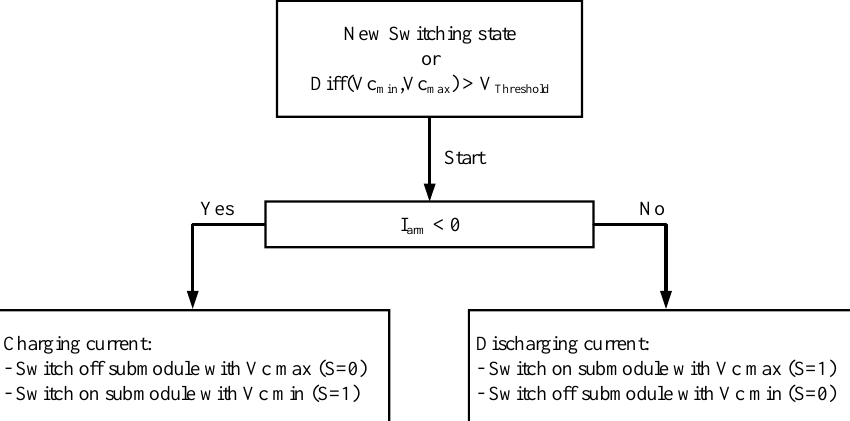
Figure 8. Capacitor voltage balancing algorithm diagram.